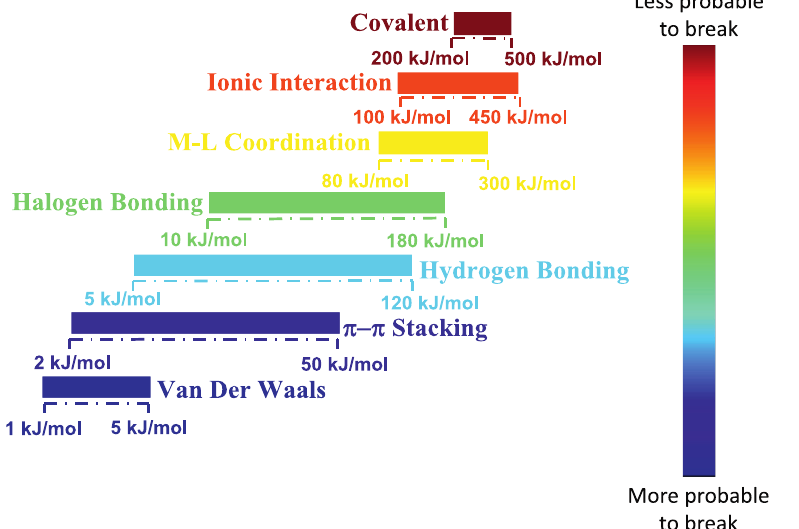
Figure 1. Energy ranges of different types of interactions, ranging from weak van der Waals to strong Fig. 1. Different types of secondary interactions and their respective binding en- ergy ranges, in kJ/mol. Inspired from [1] . The color bar represents the probability covalent bonds. Reprinted with the permission from Vereroudakis and Vlassopoulos of a bond breaking spontaneously due to thermal fluctuations. For reference, the thermal energy at room temperature (25 ° C) is RT = 2.48 kJ/mol. (For interpretation of the references to color in this figure legend, the reader is referred to the web version of this article.)